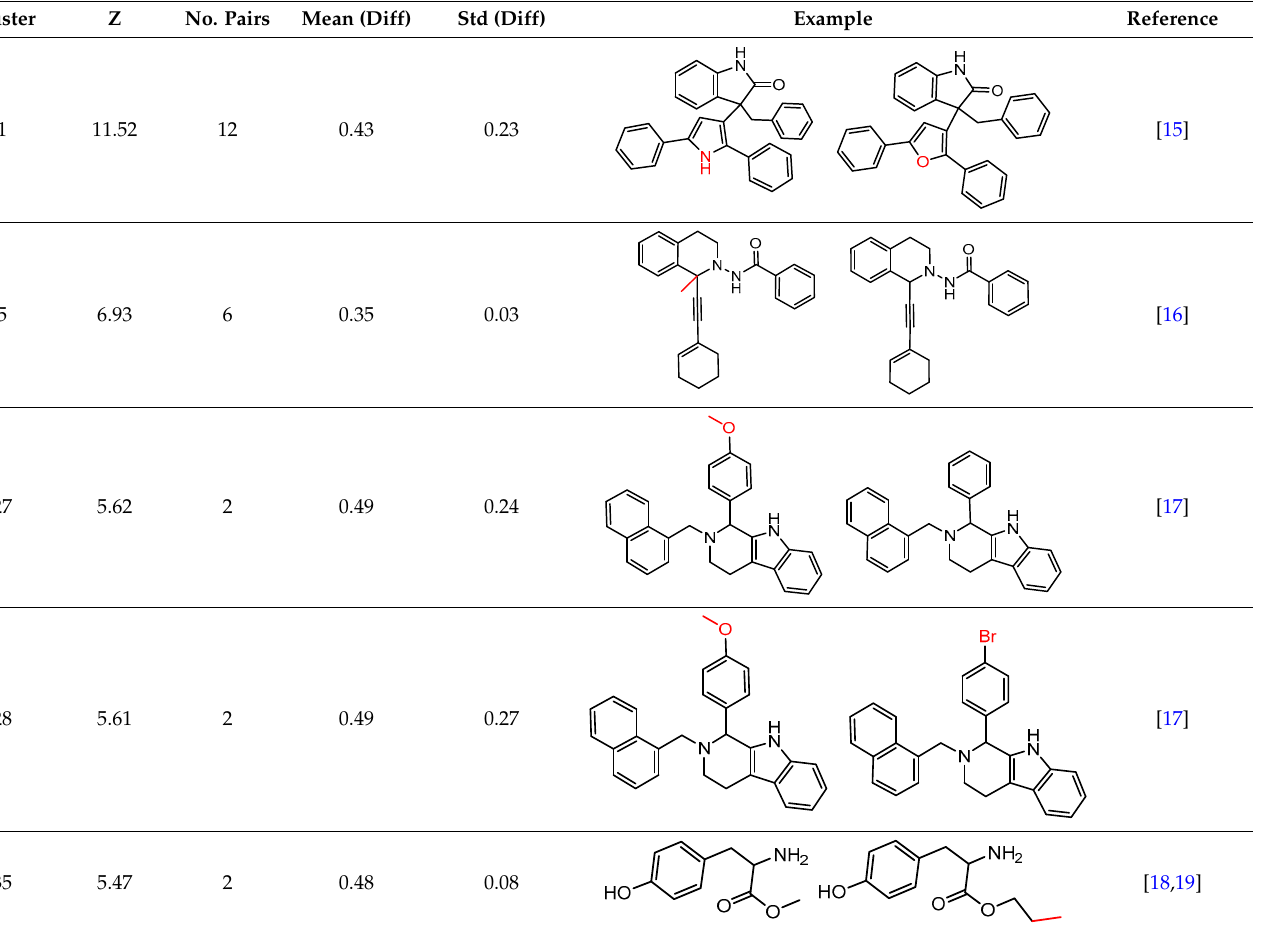
Table 2. Clusters where M > 1 and the activities for A and B come from the same reference.